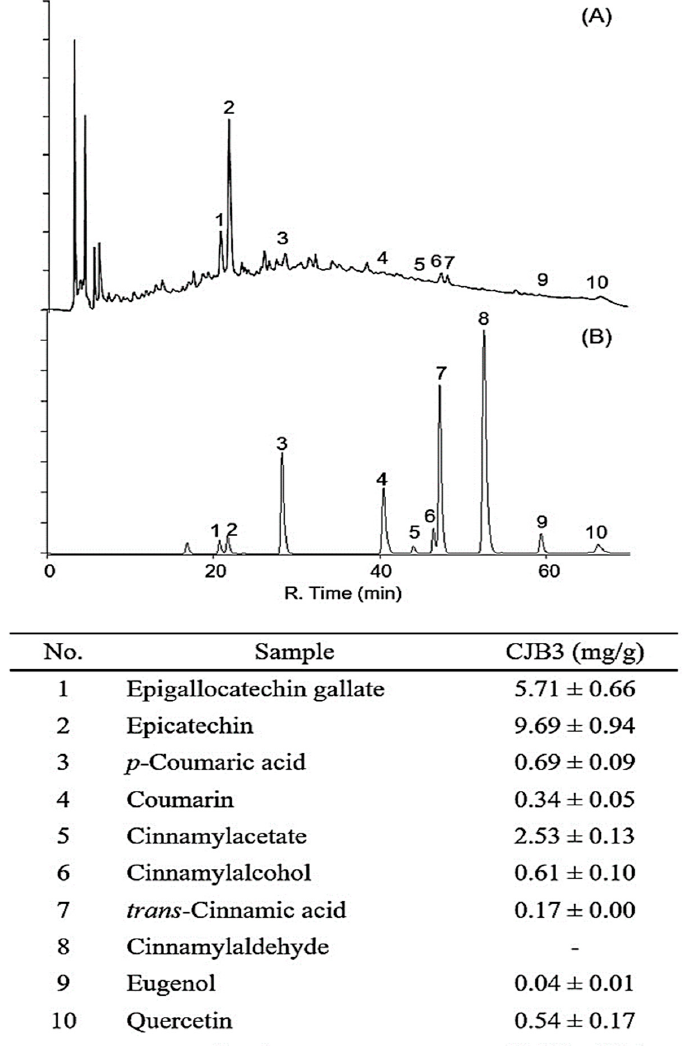
Figure 3. HPLC profile of the CJB3 and standard mixtures using diode array detection at 280 nm. ( A ) Standards and ( B ) CJB3; the numbers indicate the following: (1) Epigallocatechin gallate (2) Epicatechin (3) p -Coumaric acid (4) Coumarin (5) Cinnamylacetate (6) Cinnamylalcohol (7) Trans-Cinnamic acid (8) Cinnamylaldehyde (9) Eugenol (10) Quercetin.